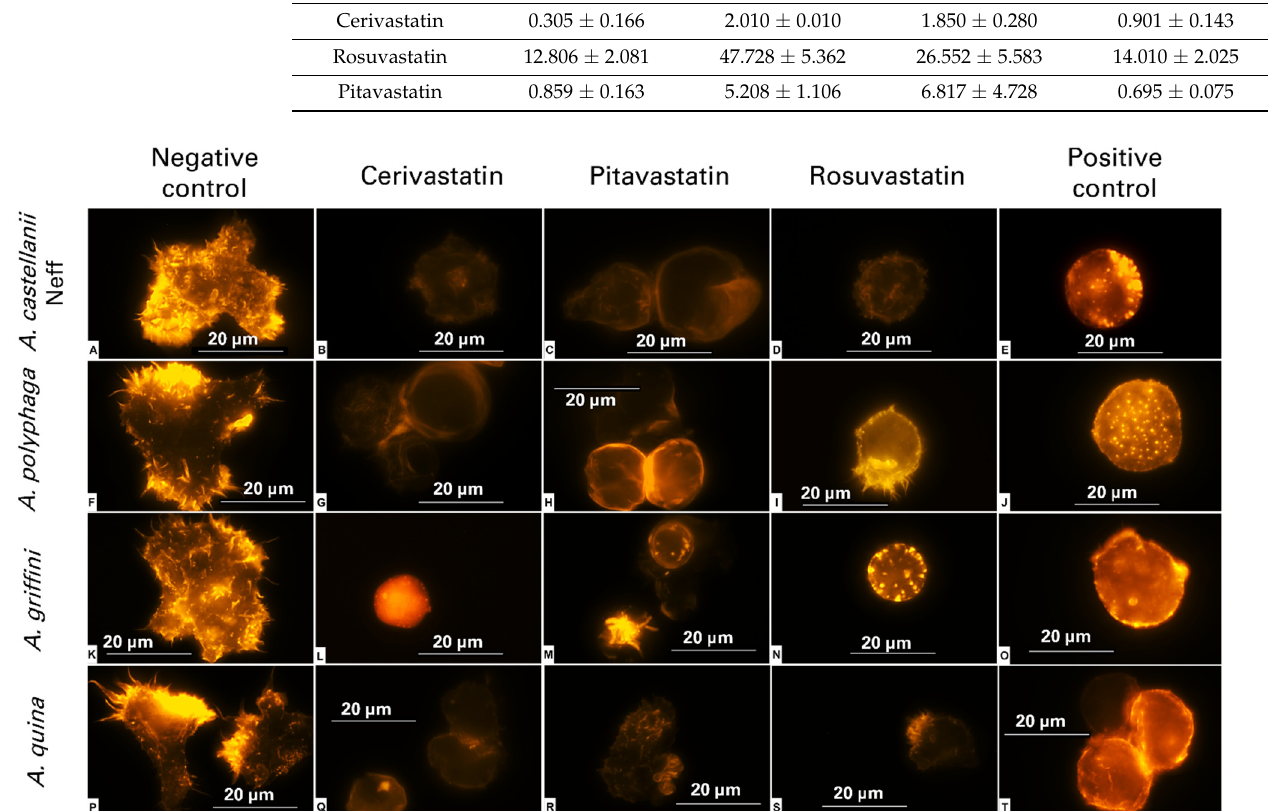
Figure 1. Trophozoites of Acanthamoeba castellanii Neff ( A – E ), A. polyphaga ( F – J ), A. griffini ( K – O ) and A. quina ( P – T ) incubated with the IC 90 of cerivastatin ( B , G , L , Q ), pitavastatin ( C , H , M , R ) and rosuvastatin ( D , I , N , S ) for 24 h. The positive control was processed by treating amoebae with methyl- β -cyclodextrin ( E , J , O , T ). The phalloidin-TRITC dye stained the actin cytoskeleton, showing a disorganization effect in the positive control and in the amoebae treated with statins, and emitted a lower orange fluorescence than the non-treated cells (negative control: A , F , K , P ). All images were captured using the EVOS FL Cell Imaging System EVOS™ M5000 (100× magnification). Images shown are representative of the cell populations observed in each experimental condition.